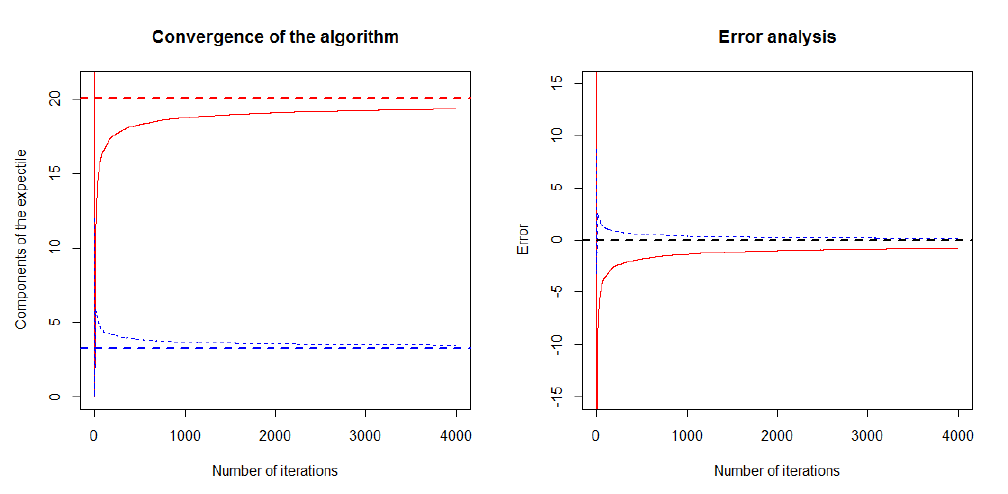
Figure 4: Convergence of the algorithm: L 1 − expectile, Exponential independent model (red β 1 = 0.05 , blue β 2 = 0.25